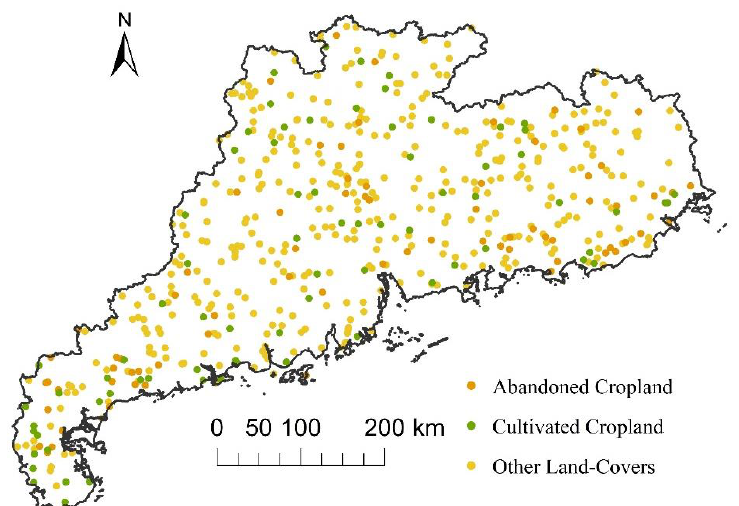
Figure 10. Example of random ground reference points distribution in Guangdong for the validation of annual cropland abandonment map in 2020. Table 1. The number of random ground reference data of Abandoned Cropland (AC), Cultivated Cropland (CC) and Other Land-Covers (OLC) for study areas in 1995, 2000, 2005, 2010, 2015 and